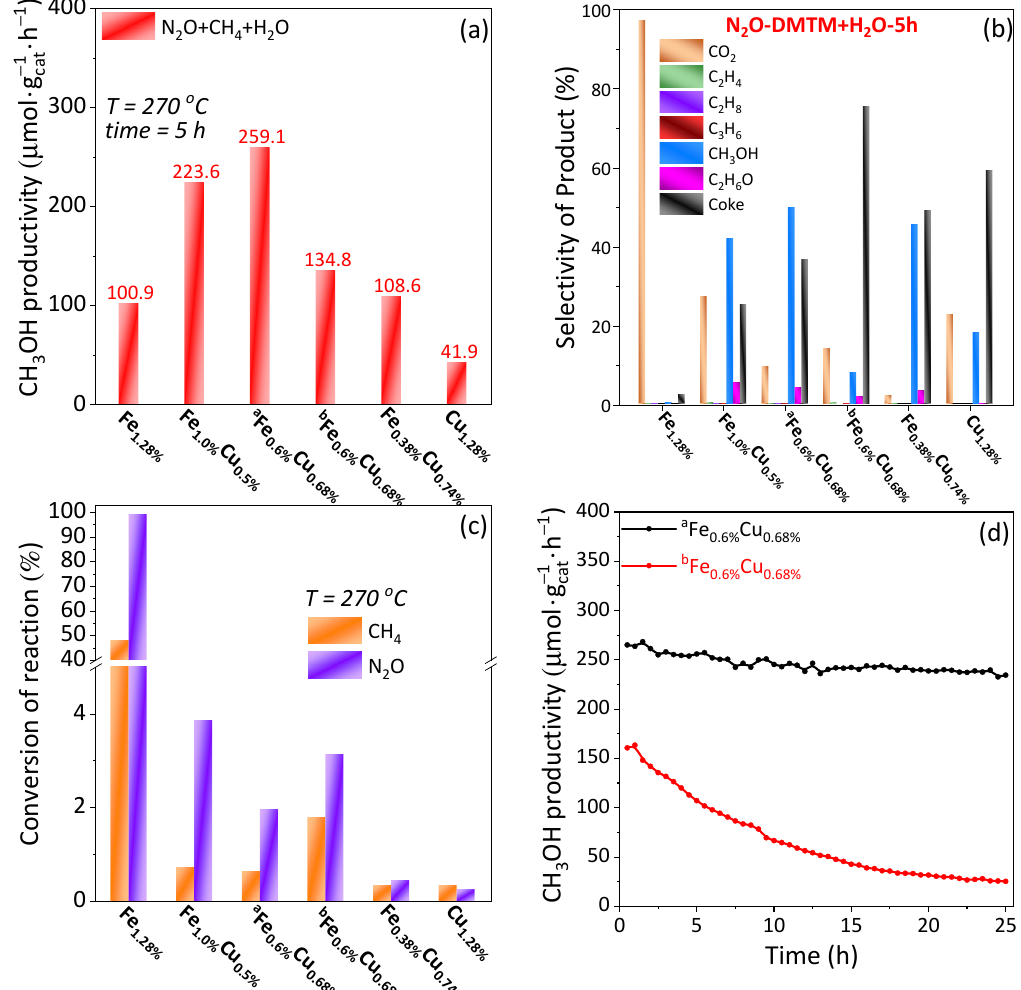
Figure 2. Activity measurement results of H 2 O-mediated continuous N 2 O DMTM over Fe n Cu m -BEA and Cu 1.28% - and Fe 1.28% -BEA; as noted, for the purpose of better description, the activity measurement results for the sample of Fe 0.6% Cu 0.68% - BEA evaluated in both scenarios of presence ( a Fe 0.6% Cu 0.68% ) and absence of H 2 O ( b Fe 0.6% Cu 0.68% ) are depicted in Figure 2: ( a ) CH3OH productivity derived as an average value after a 5 h reaction; ( b ) product selectivity; the selectivities for the Fe 0.6% Cu 0.68% -BEA samples were derived from 25 h of activity measurement; ( c ) reactant conversion of CH 4 and N 2 O; ( d ) 25